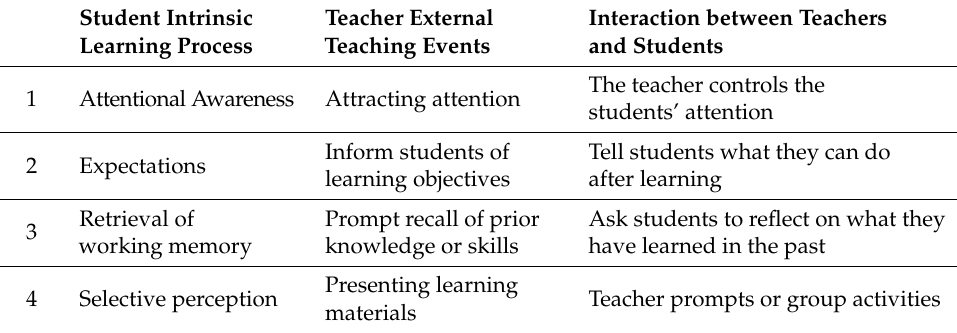
Table 2. The internal learning process and its corresponding external teaching events.